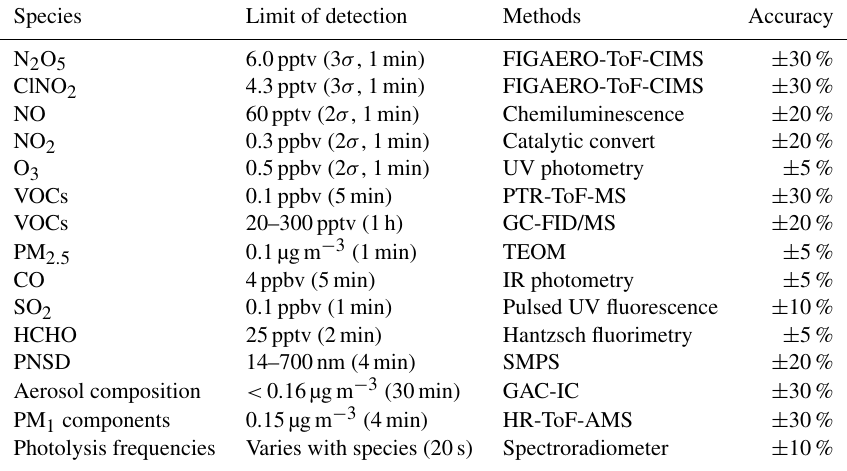
Table 1. Summary of the information about observed gas and particle parameters during the